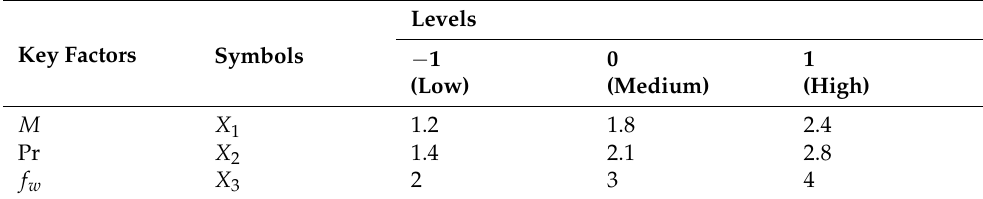
Table 3. Key RSM parameters, their levels, and their